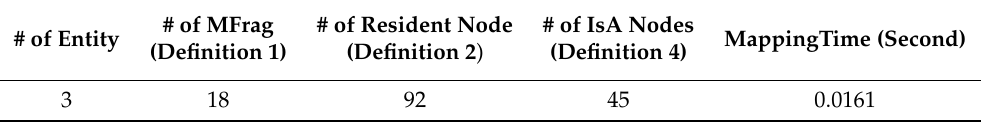
Table 7. The Results of the MEBN-RM Mapping for the Partial MSAW Relational Database (Figure 5) and Its Mapping Time.